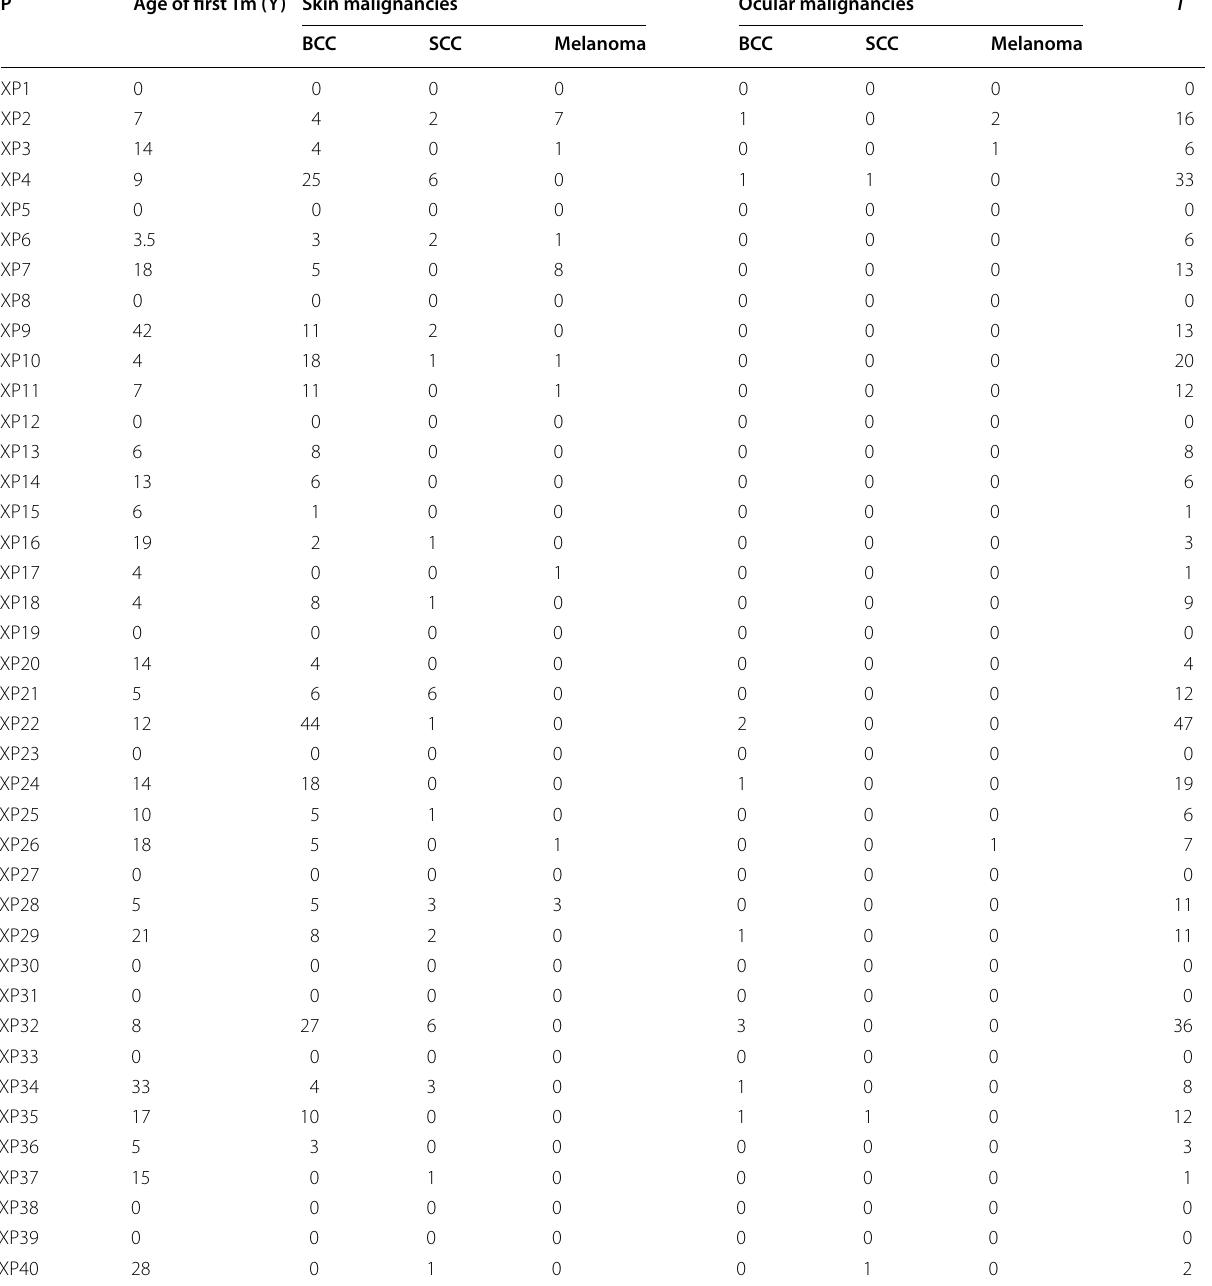
Table 2 Type and number of malignancies developed in the 40 studied Moroccan Xeroderma pigmentosum